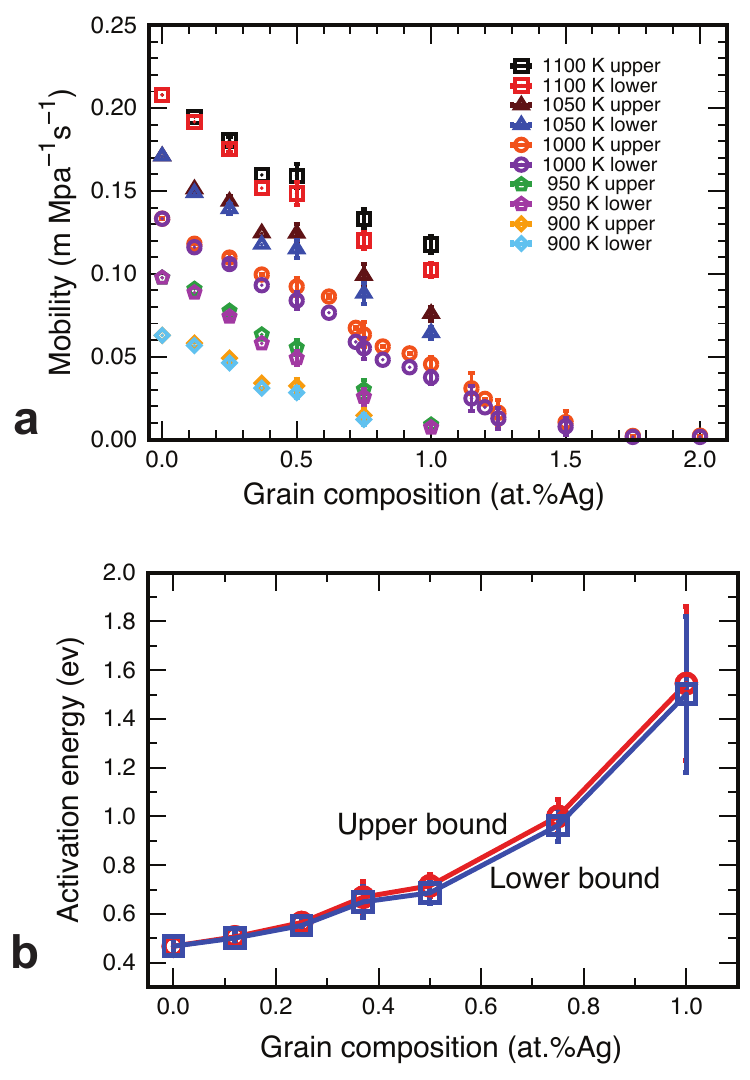
Figure 12. ( a ) The upper and lower bounds of the GB mobility coefficient as a function of temperature and alloy composition. ( b ) The upper and lower bounds of the activation energy of GB mobility as a function of alloy